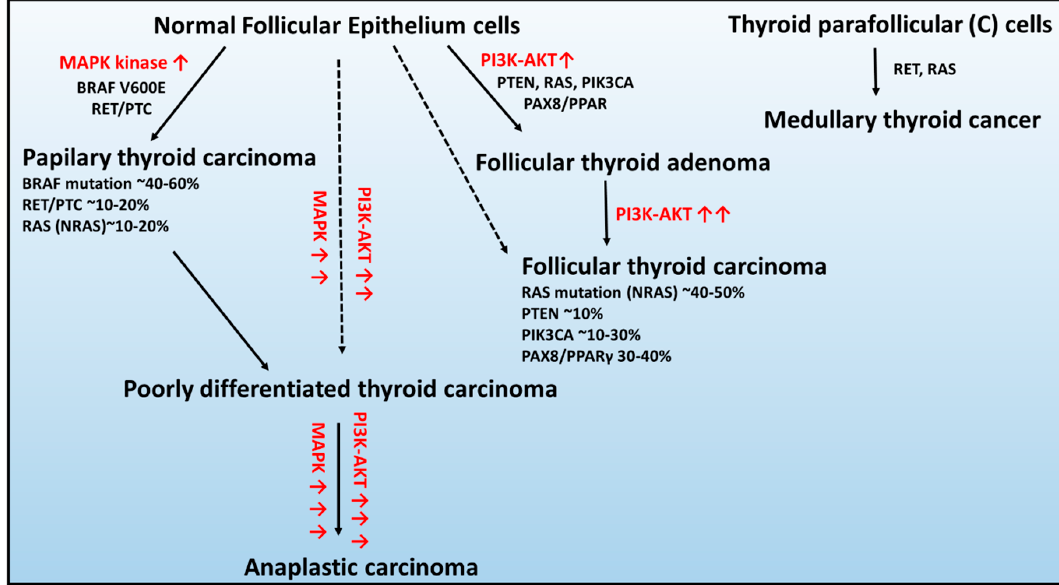
Figure 1. Schematic of the genetic abnormalities associated with the development and progression of thyroid cancers developed from healthy epithelium cells: ( 1 ) follicular thyroid adenoma, ( 2 ) papillary thyroid carcinoma, ( 3 ) follicular thyroid carcinoma, and ( 4 ) anaplastic thyroid carcinoma and parafollicular thyroid cells: medullary thyroid carcinoma. Figure adapted from [45]. Red arrow signifies overactivation of signaling pathway.